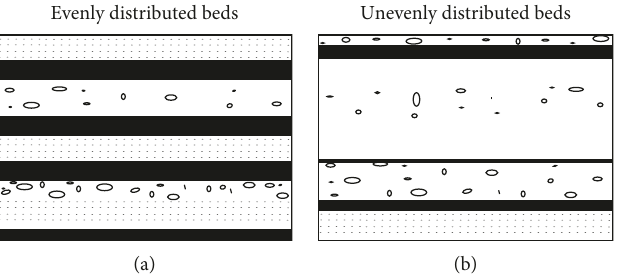
Figure 1: The two-types of packages found at the key sites: (a) evenly distributed beds contain a relatively even distribution of interbedded clay layers (in black) throughout the package; (b) unevenly distributed beds contain a sparse or random arrangement of clay beds relative to the other lithofacies (e.g., siltstone, sandstone, conglomerates)